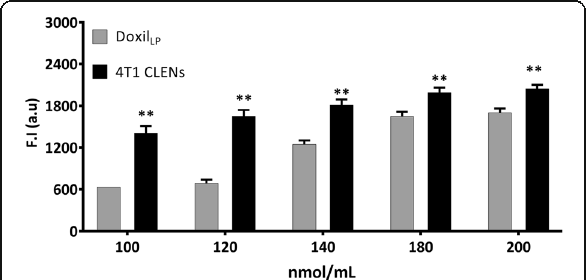
Fig. 3 BT-20 cellular uptake studies. An amount of 1 × 10 4 BT-20 cells were seeded in a 48 well plate. After 24 h, cells were exposed to different concentrations of fluorescently labeled CLENs for 24 h. The data show cellular uptake of CLENs by all the cells, with the highest degree of uptake observed with BT-20 cells, and the least amount of cellular uptake was observed with the (negative control) ovarian cancer cell line, SK-OV-3. Data are presented as mean ± S.D.; ( n = 6)